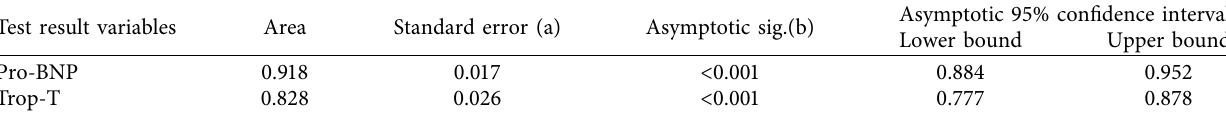
Table 9: Prediction of pulmonary hypertension ( ≥ 20 mmHg) by serum pro-BNP and troponin T values (Figure 3: ROC curve).